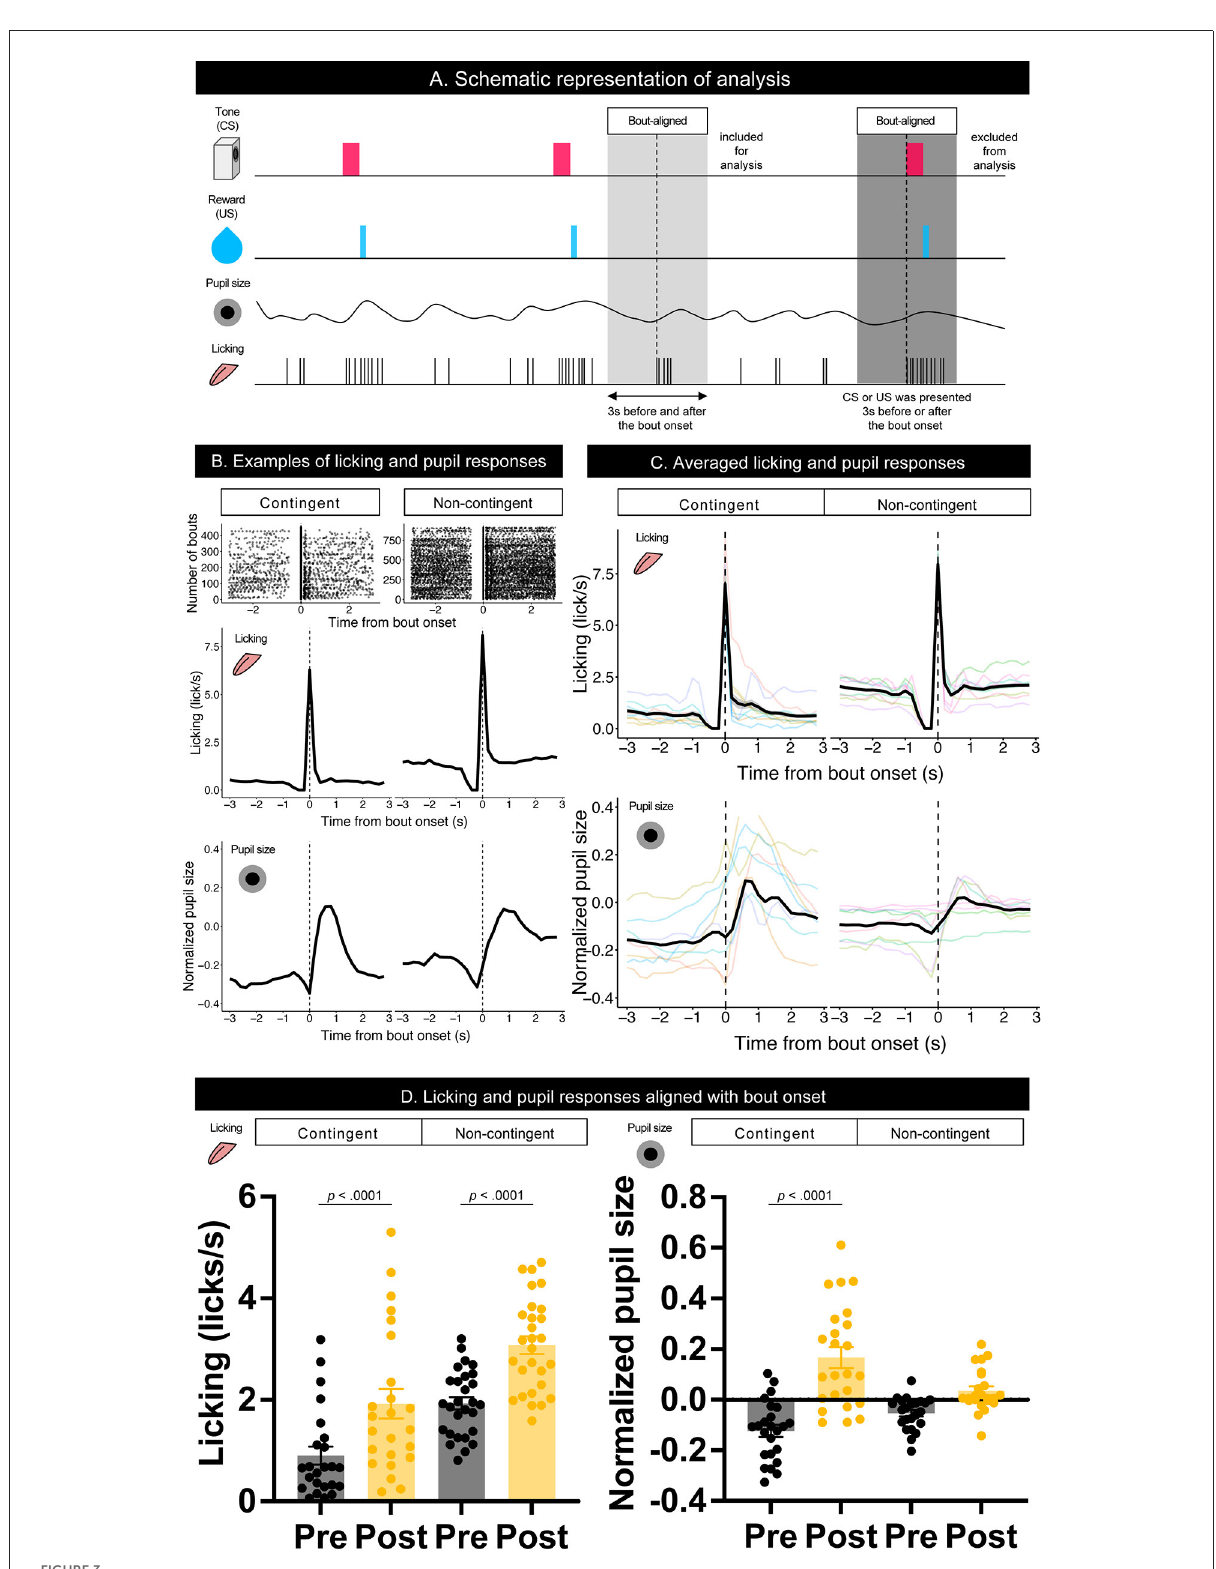
FIGURE3 Temporal changes in licking responses and pupil size aligned with onsets of bouts. (A) Schematic representation of the response bout analysis. Initiation of the bout was set as 0, and the 3s before and after bout initiation was used for the analysis. (B) Examples of raster plots before